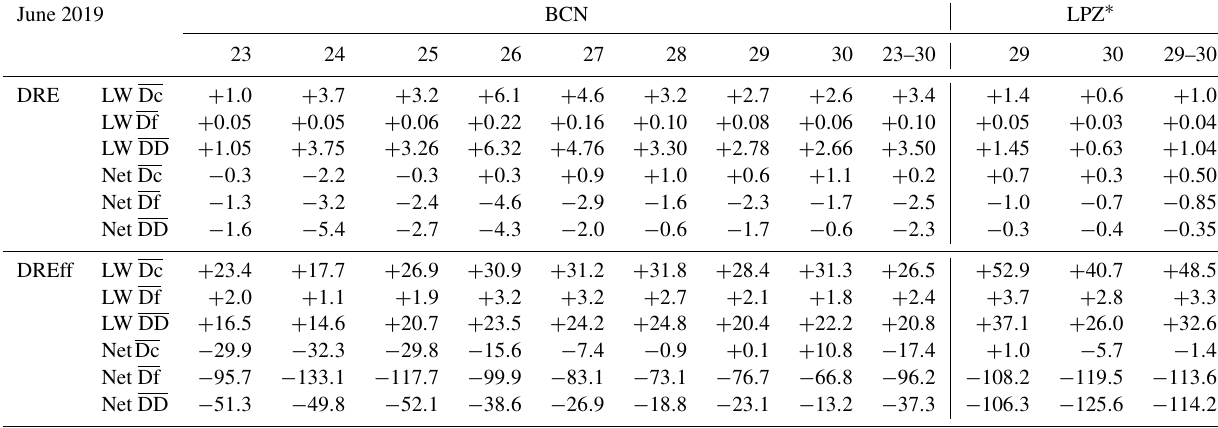
Table 2. Same as Table 1 but at the TOA. DOD 532 values are shown in Table